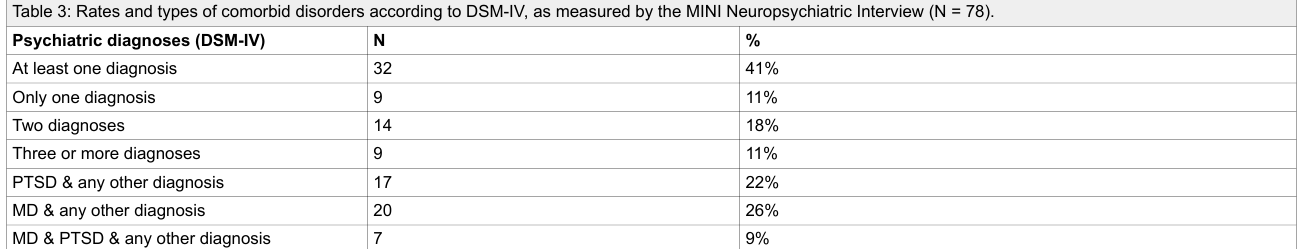
Table 3: Rates and types of comorbid disorders according to DSM-IV, as measured by the MINI Neuropsychiatric Interview (N = 78). Psychiatric diagnoses